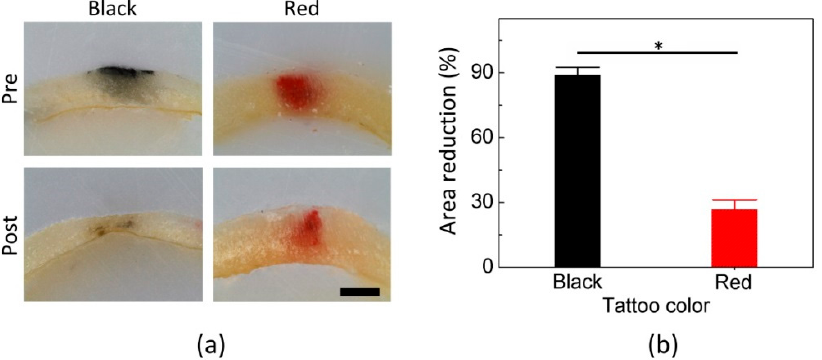
Figure 5. Variations in tattoo distribution before and after laser treatment: ( a ) cross-sectional images of tattooed tissue before (pre) and two weeks after (post) laser treatment for black (left column) and red (right column), and ( b ) degree of tattoo reduction after single laser treatment (bar = 500 µm; N = 3; * p < 0.001).